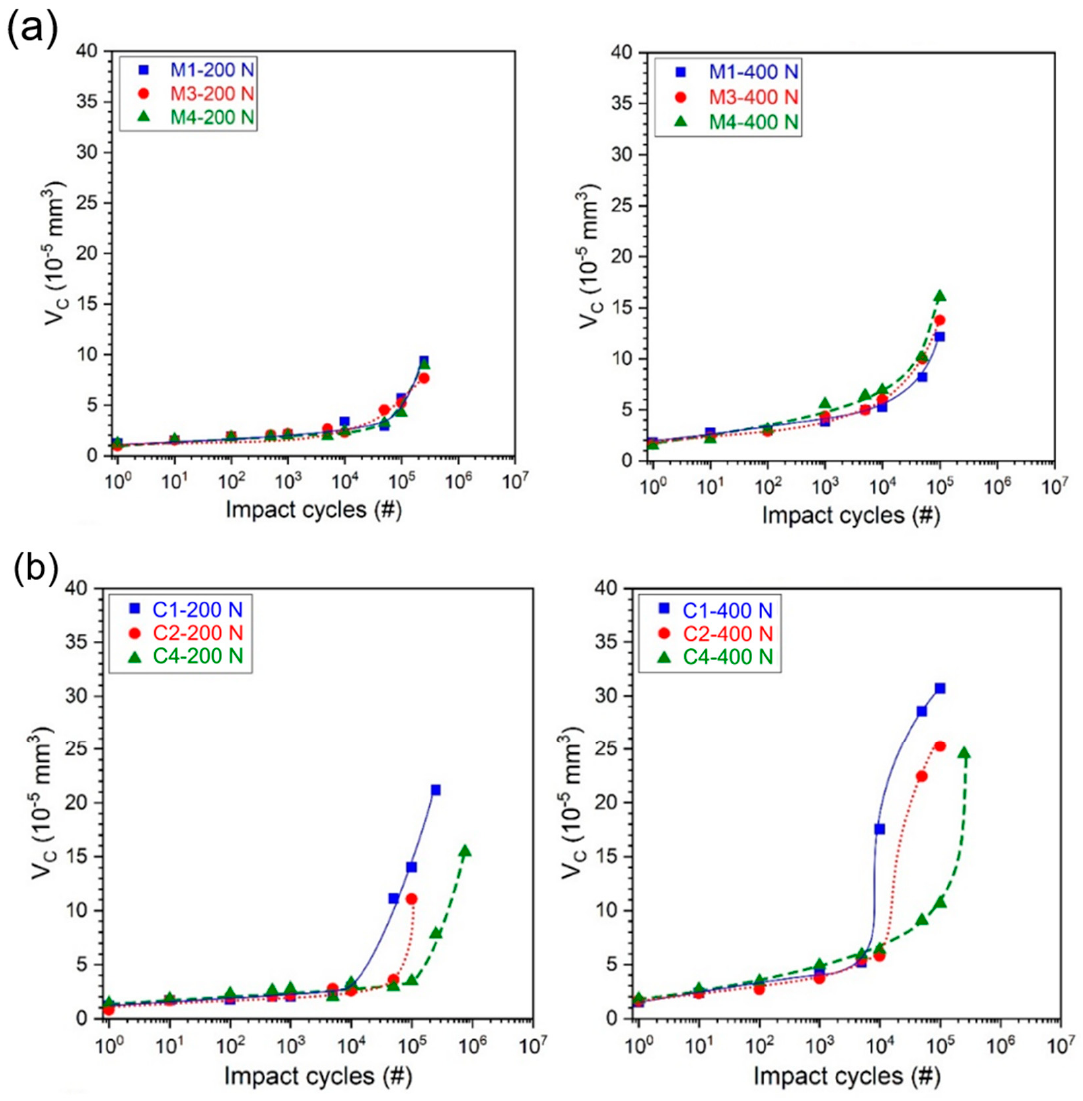
Figure 3. Variation in residual impact crater volume (V C ) as a function of impact cycles at various impact loads for selected AlCrN ( a ) M-coatings and ( b ) C-coatings.